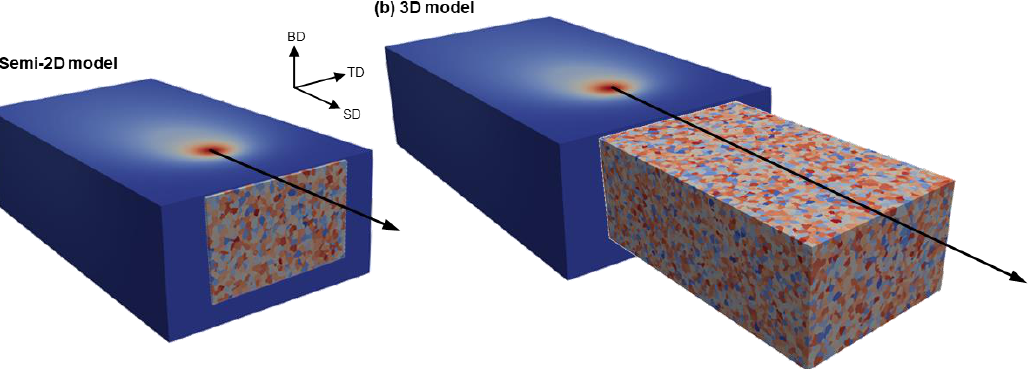
Figure 3. The computational domains for ( a ) semi-2D and ( b ) 3D analyses.